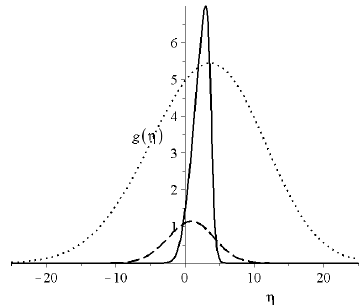
Figure 1. The graphs of Equation (2.5) for various parameter sets. The solid curve is for c 4 = 0 . 5 ,a = 0 . 5 ,ν = 1 . 6 ,ρ 1 = 2 ,ρ 2 = 1 the dotted line is for c 4 = 0 . 9 ,a = 0 . 27 ,ν = 10 . 4 ,ρ 1 = 2 ,ρ 2 = 6 and the dashed curve is for c 4 = 0 . 2 ,a = 0 . 27 ,ν = 40 ,ρ 1 = 2 ,ρ 2 = 20,